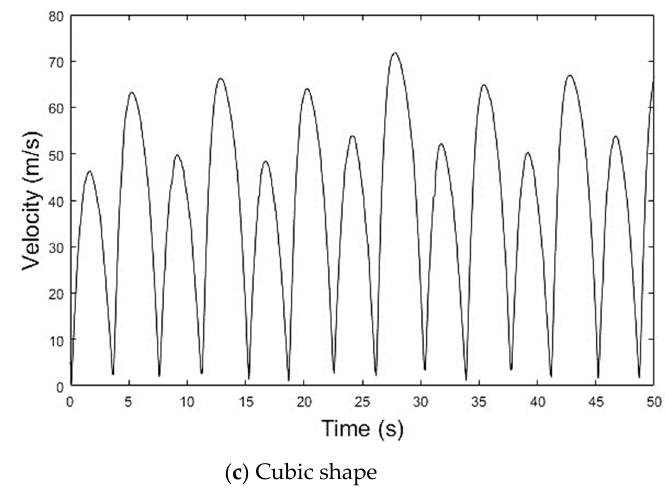
Figure 9. Velocity of air-flow corresponding to various shapes of OWC chamber.